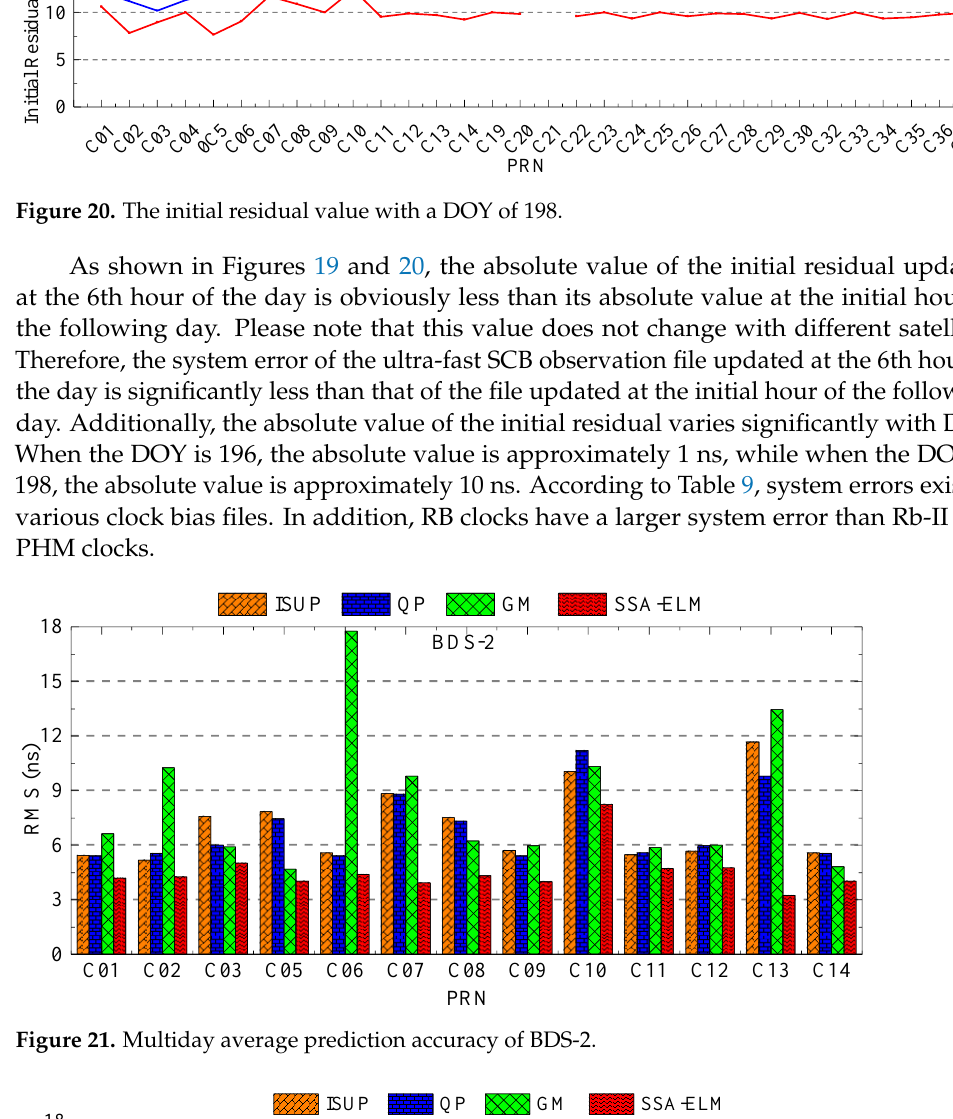
Figure 22. Multiday average prediction accuracy of BDS-3.